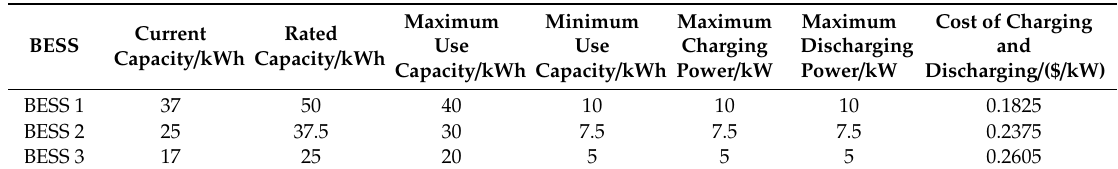
Table 8. Parameters of multi-BESSs.